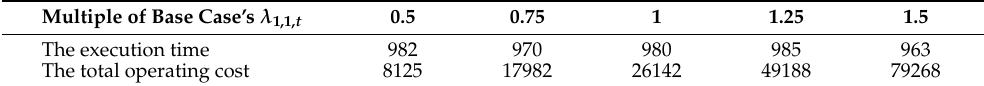
Table 6. The execution time and optimization results in case 2.